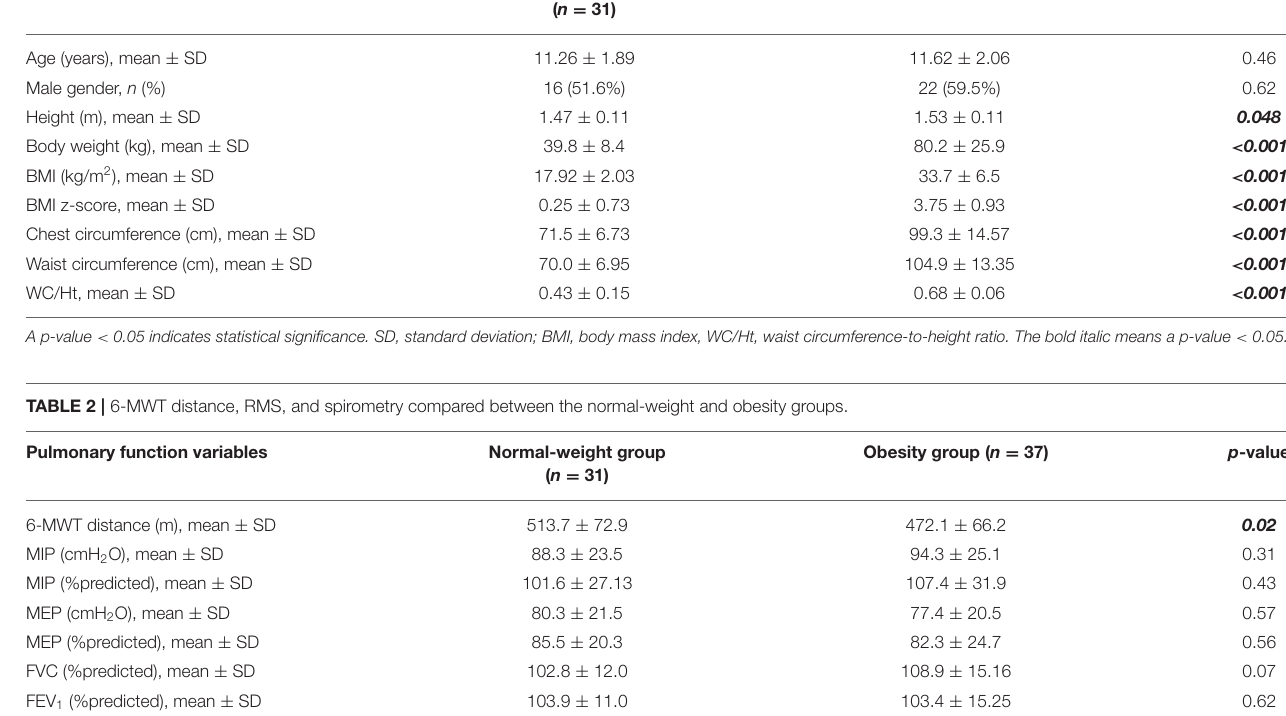
TABLE 1 | Demographic data and obesity indices compared between the normal-weight and obesity groups. Data